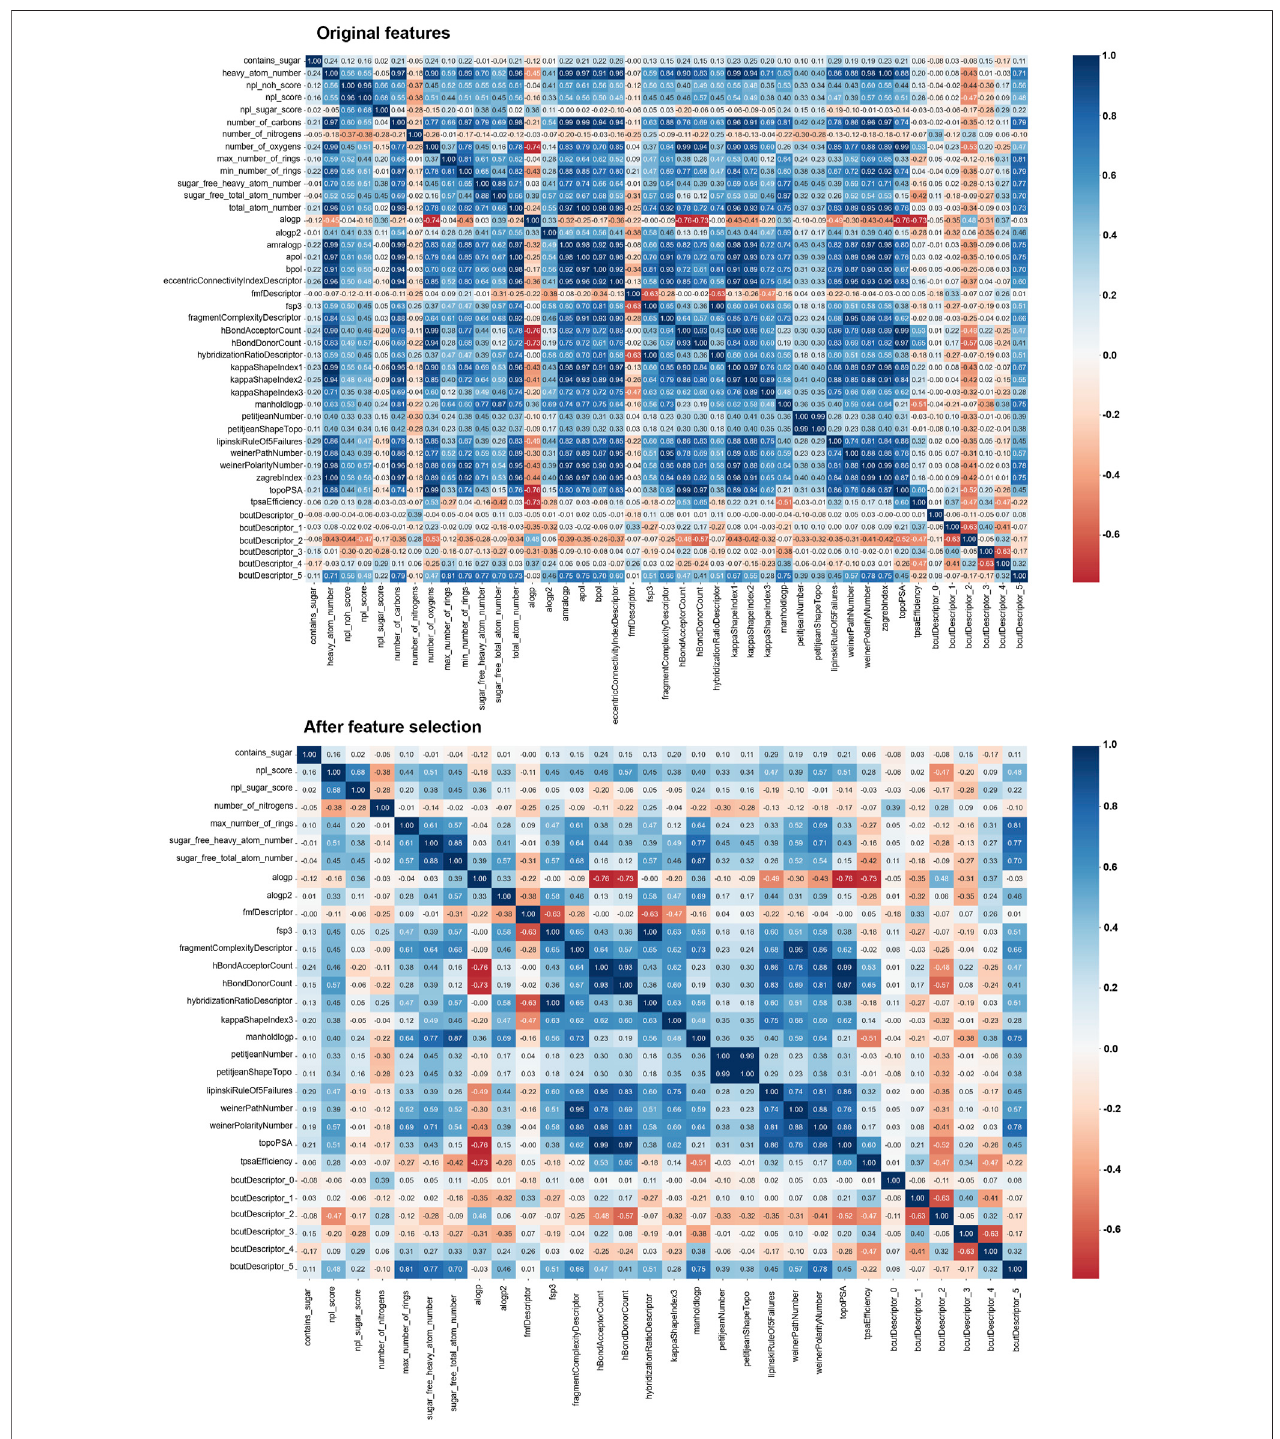
FIGURE 7 | Correlation matrix for the features used for the chemical library used in this work.